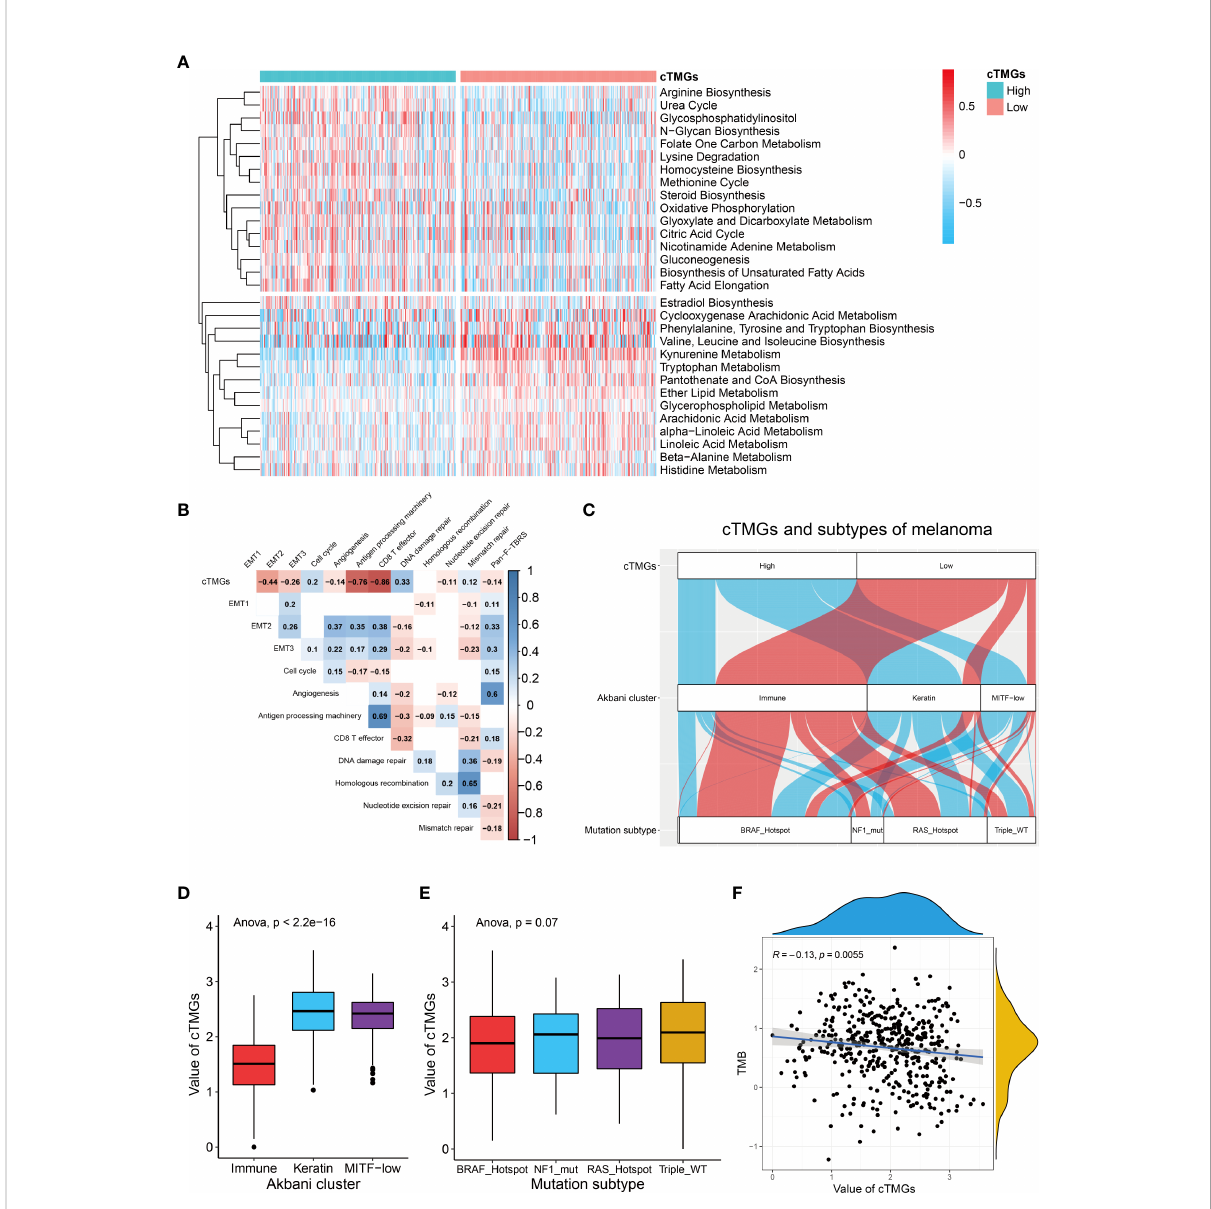
FIGURE 4 cTMGs negatively correlated with tumor immunity in CM. (A) Enrichment analysis of differential genes between high- and low-cTMGs groups. (B) Correlation analysis between cTMGs and the biological pathways in the TCGA_SKCM dataset. (C) Sankey diagram showed the connection degree between cTMGs, Akbani cluster, and mutation subtype in the TCGA_SKCM dataset. (D) Box plot showing a difference in the value of cTMGs across the three Akbani clusters for CM patients in the TCGA_SKCM dataset. (E) Box plot showing the difference in the value of cTMGs across the four mutation subtypes for CM patients in the TCGA_SKCM dataset. (F) Scatter plot shows the correlation between TMB and